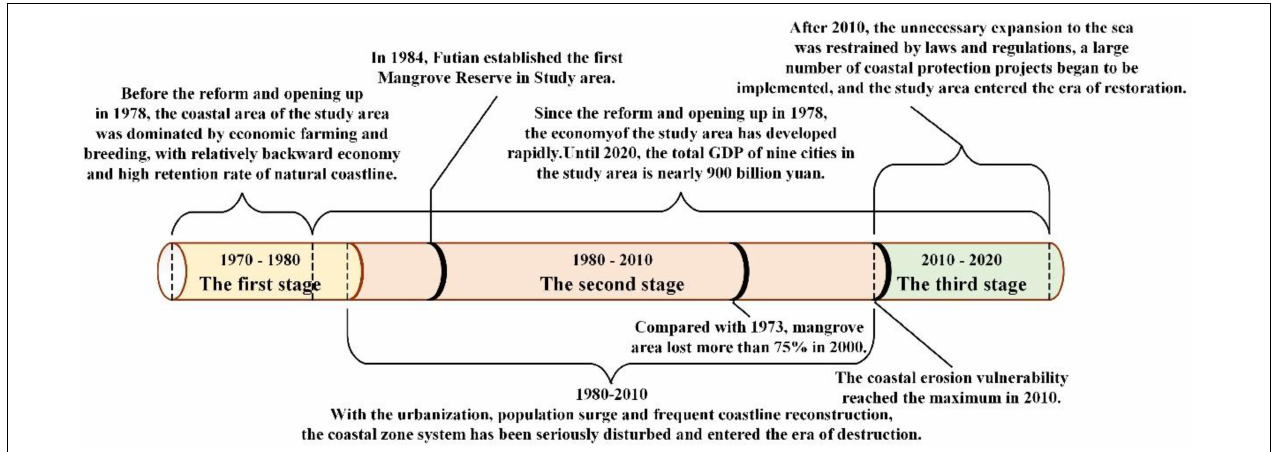
FIGURE 9 | Timeline showing the development process in the study area, which can be divided into three stages. The first stage is the low coastal erosion vulnerability period from 1970 to 1980, the second stage is the period of coastal system damage with vulnerability growth from 1980 to 2010, and the third stage is the period of coastal ecological system recovery with vulnerability decline from 2010 to